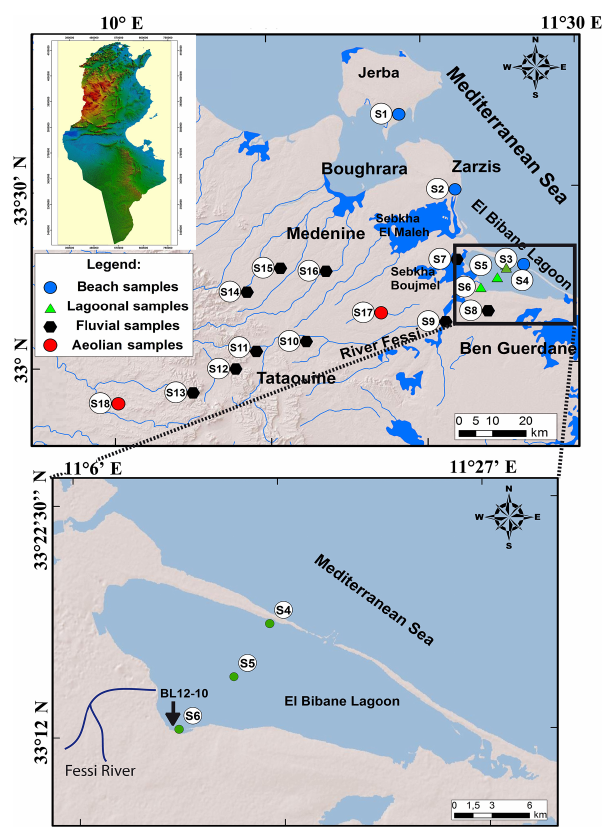
Figure 3. Location of the investigated surface samples from the catchment basin and from the El Bibane